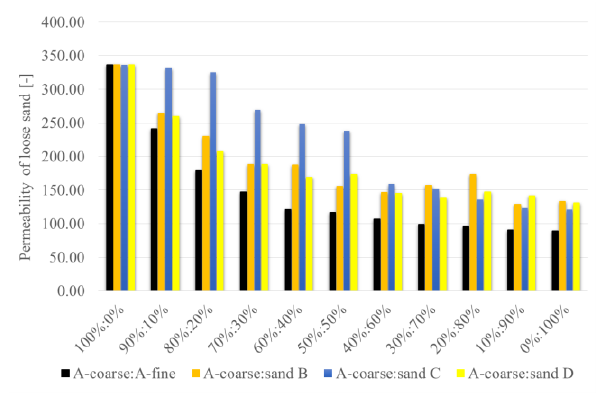
Figure 11. Results of the measurement of loose sand permeability.